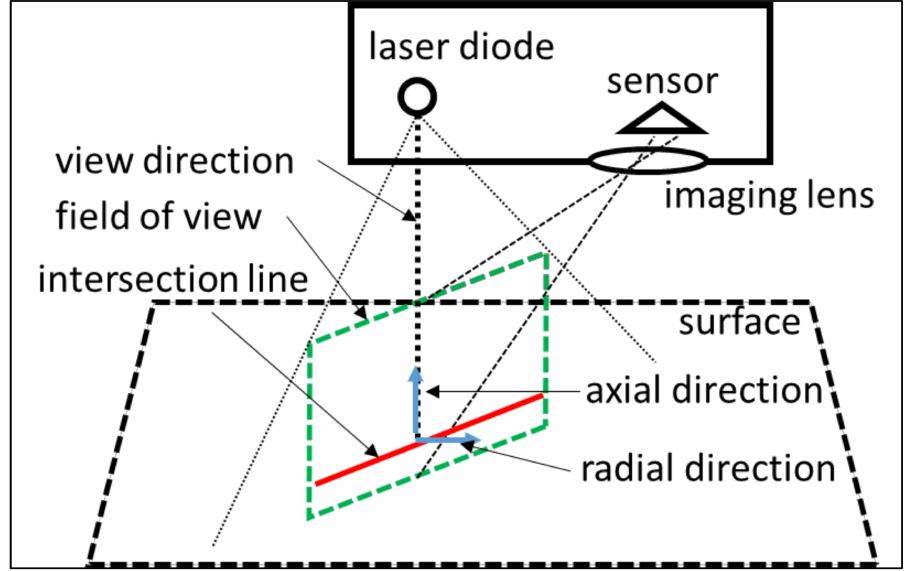
Figure 8. Triangulation principle of an LLS based on